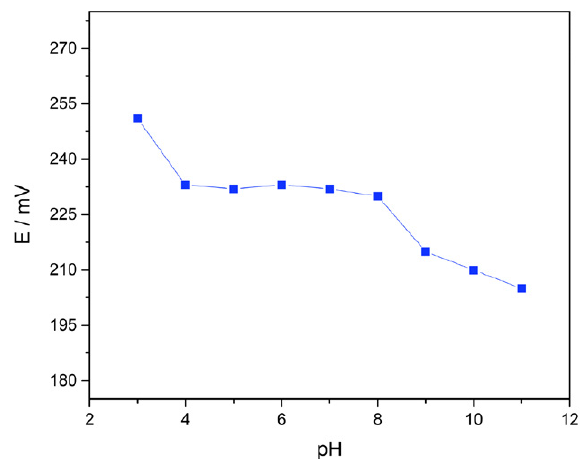
Figure 7. Effect of pH on the DOP-selective microsensor response